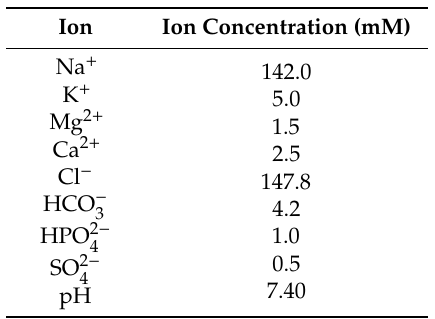
Table 2. The ion concentrations of the SBF solution